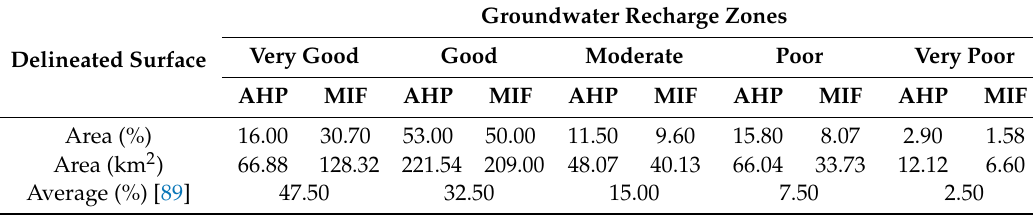
Table 11. Groundwater recharge potential zones and